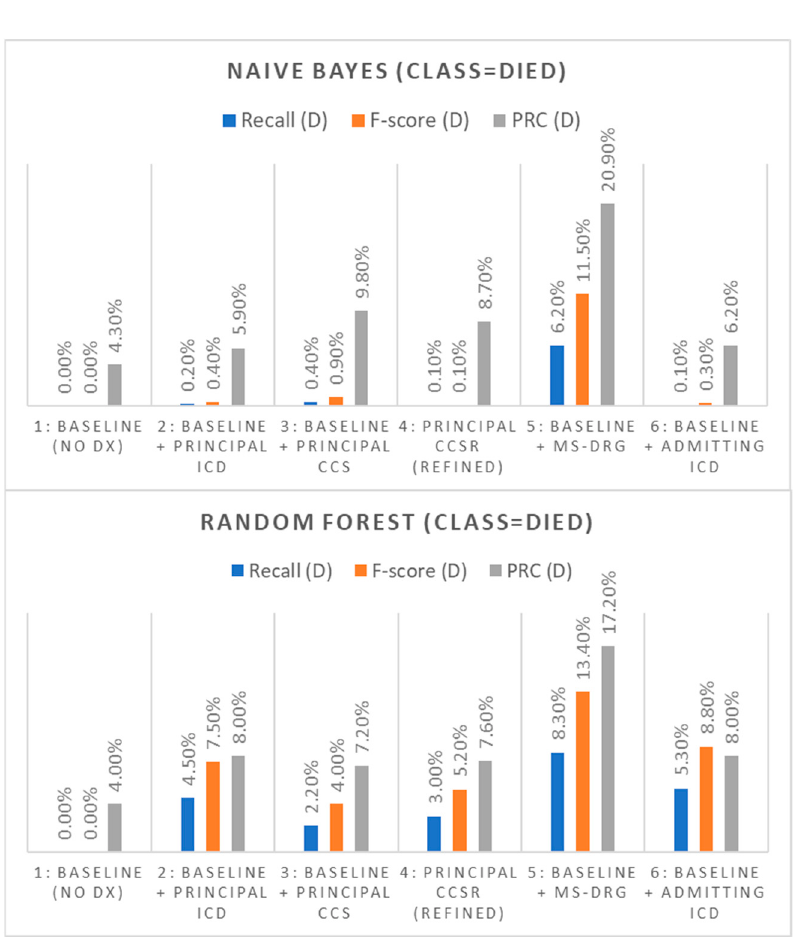
Figure 2. Performance comparison of the Dx code constructs for the outcome of inpatient mortality.